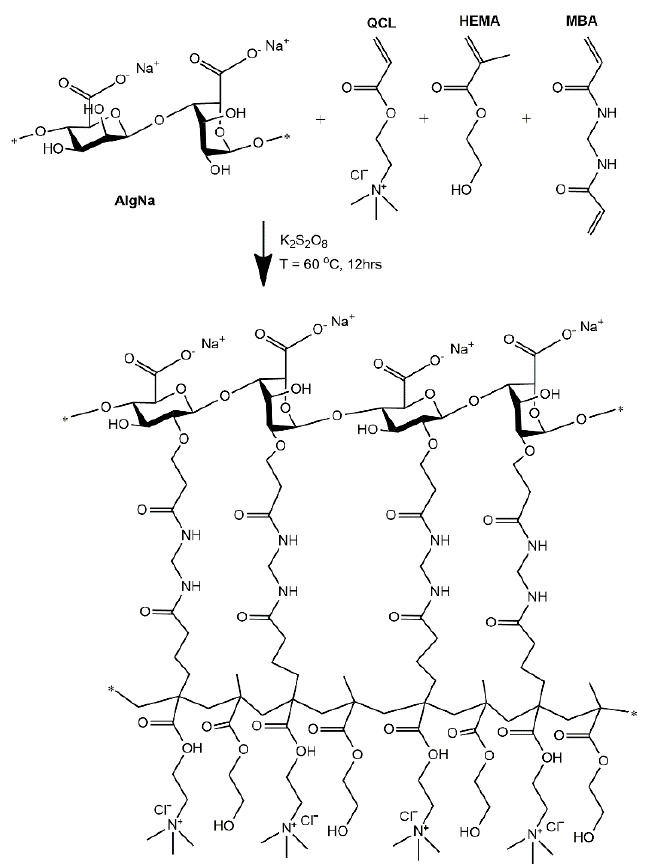
Figure 1. Schematic representation of chemical structures of polymer, monomers, and hypothetically cross-linked structures of AlgNa-g-poly(QCL-co-HEMA) hydrogels.